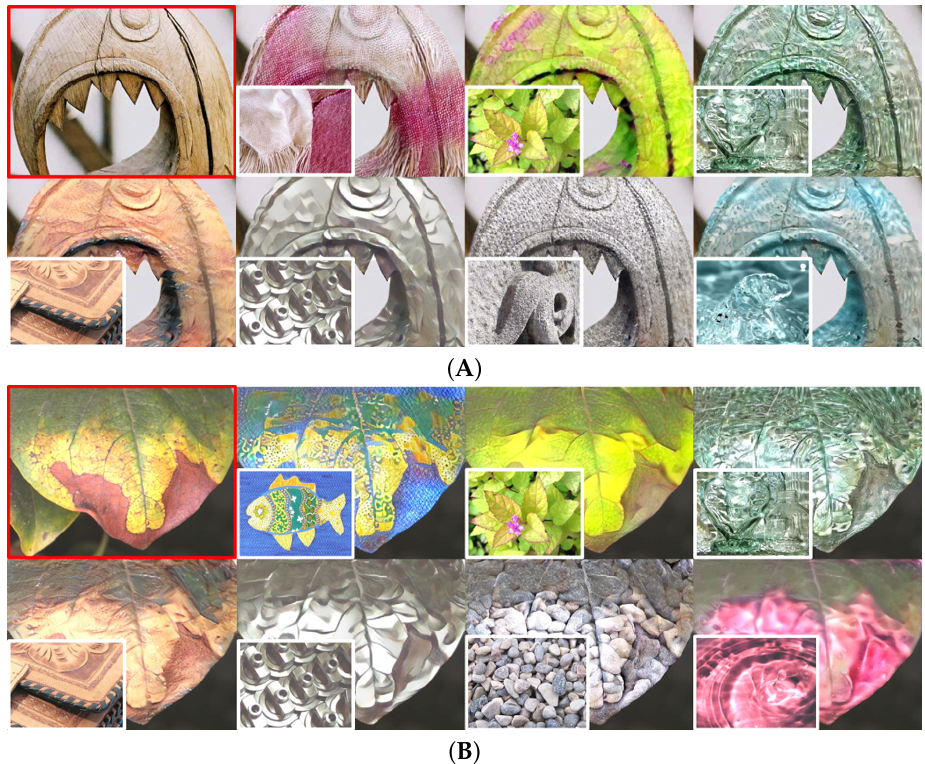
Figure 9. Translated results using our VGG19-IN proposal. ( A ) from wood, and ( B ) from foliage material (content image in red). From left to right, and top to bottom: content image, results of fabric, foliage, glass, leather, metal, stone, and